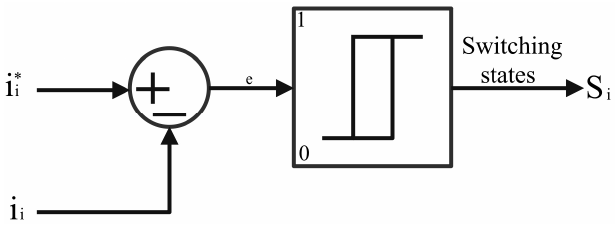
Figure 3. Operation of the hysteresis current controller.